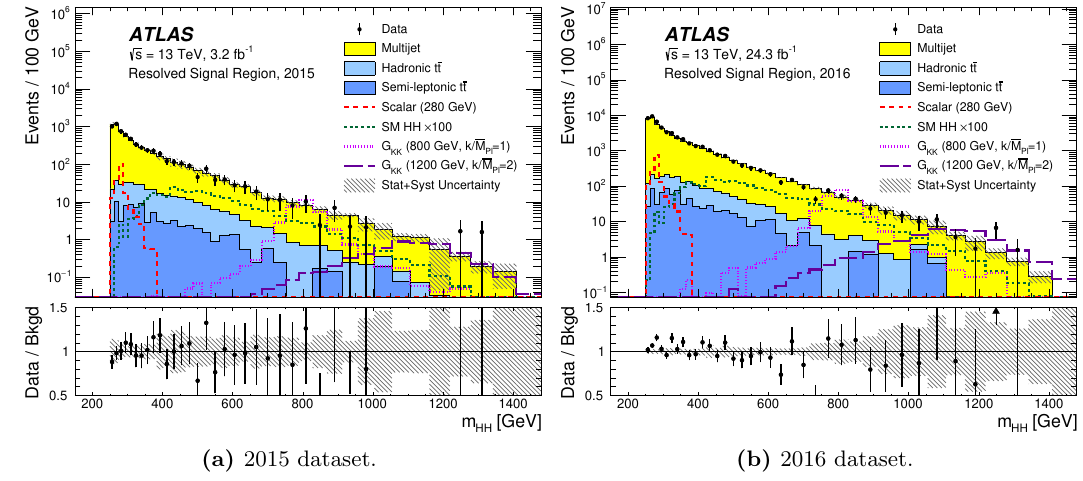
Figure 4. Distributions of m 4j in the signal region of the resolved analysis for (a) 2015 data and (b) 2016 data, compared to the predicted backgrounds. The hatched bands represent the combined statistical and systematic uncertainties in the total background estimates. The expected signal distributions of G KK resonances with masses of 800 and 1200 GeV, a 280 GeV scalar sample and SM non-resonant HH production ( (cid:2) 100) are also shown. The scalar sample is normalized to a cross section times branching ratio of 2.7